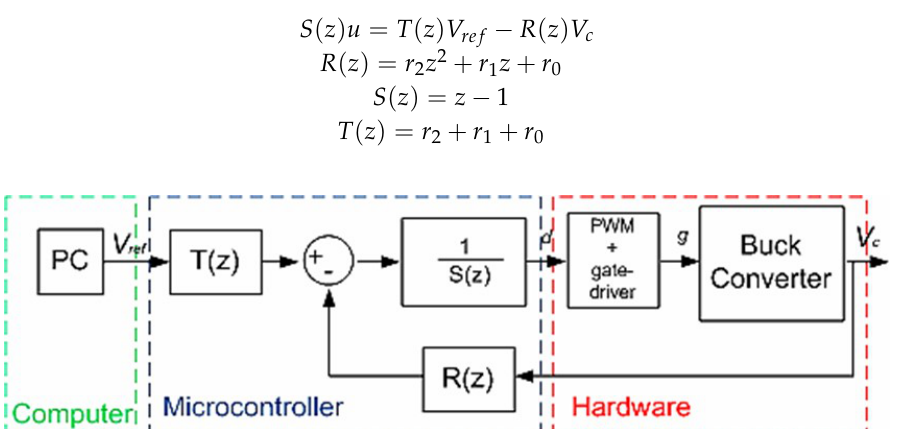
Figure 7. Generic block diagram of the control RST topology